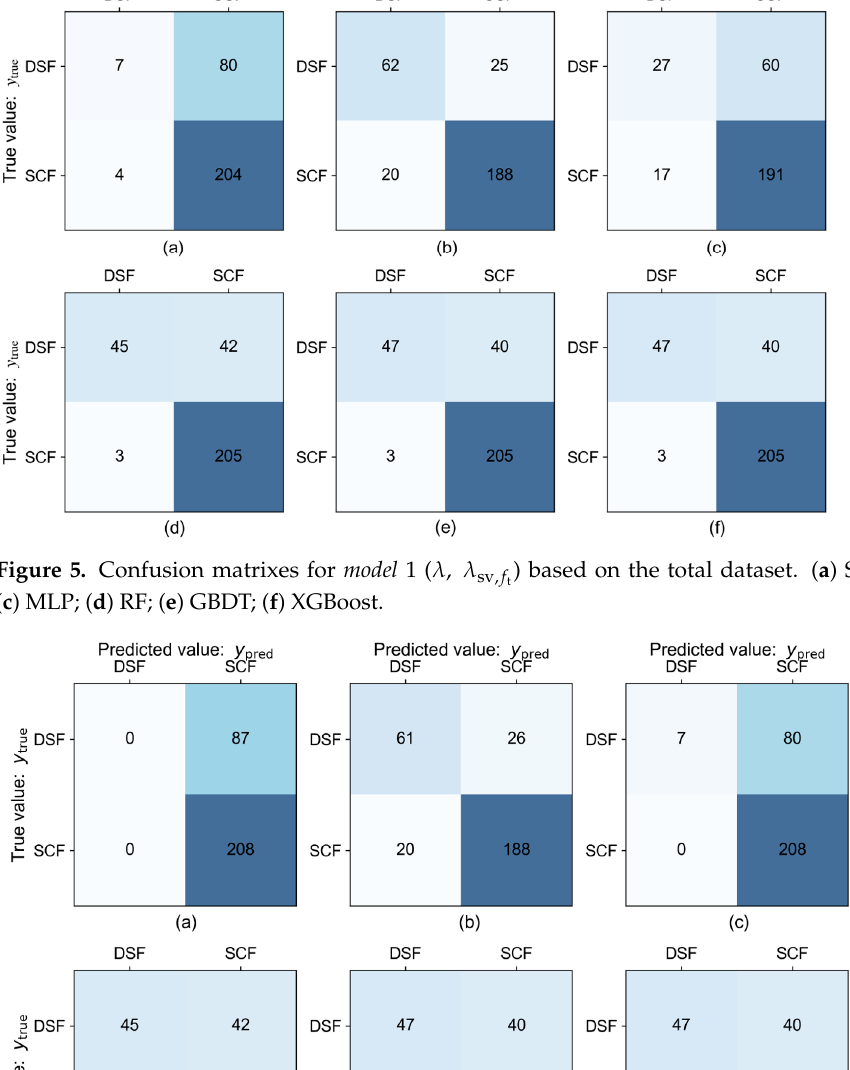
Figure 6. Confusion matrixes for model 2 ( 𝜆 , 𝜆 (cid:2929)(cid:2932) , (cid:3033) (cid:3161)(cid:4594) ) based on the total dataset. ( a ) SVM; ( b ) DT; ( c ) MLP; ( d ) RF; ( e ) GBDT; ( f ) XGBoost